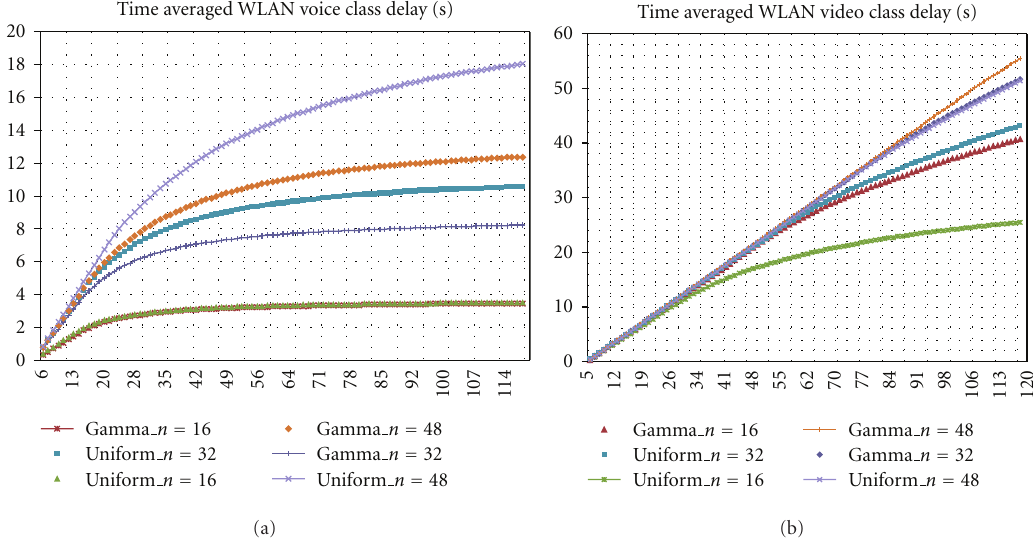
Figure 7: As illustrated, each bundle includes two simulations: one Gamma curve and one PDF curve. (right): Video class’s service delay is worse in Gamma case than Uniform case. However, the di ff erence is lessened when number of stations increases. (left): Voice class delay in Gamma Scenarios always is lower than Uniform